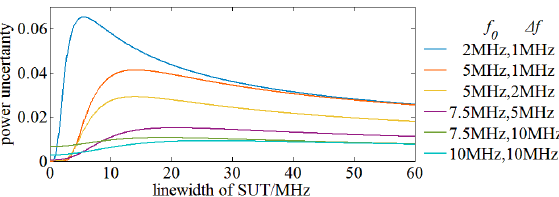
Figure 7. The power uncertainty of complex monochromatic SUT achieved with Butterworth RBW filter of different center frequency and bandwidth.